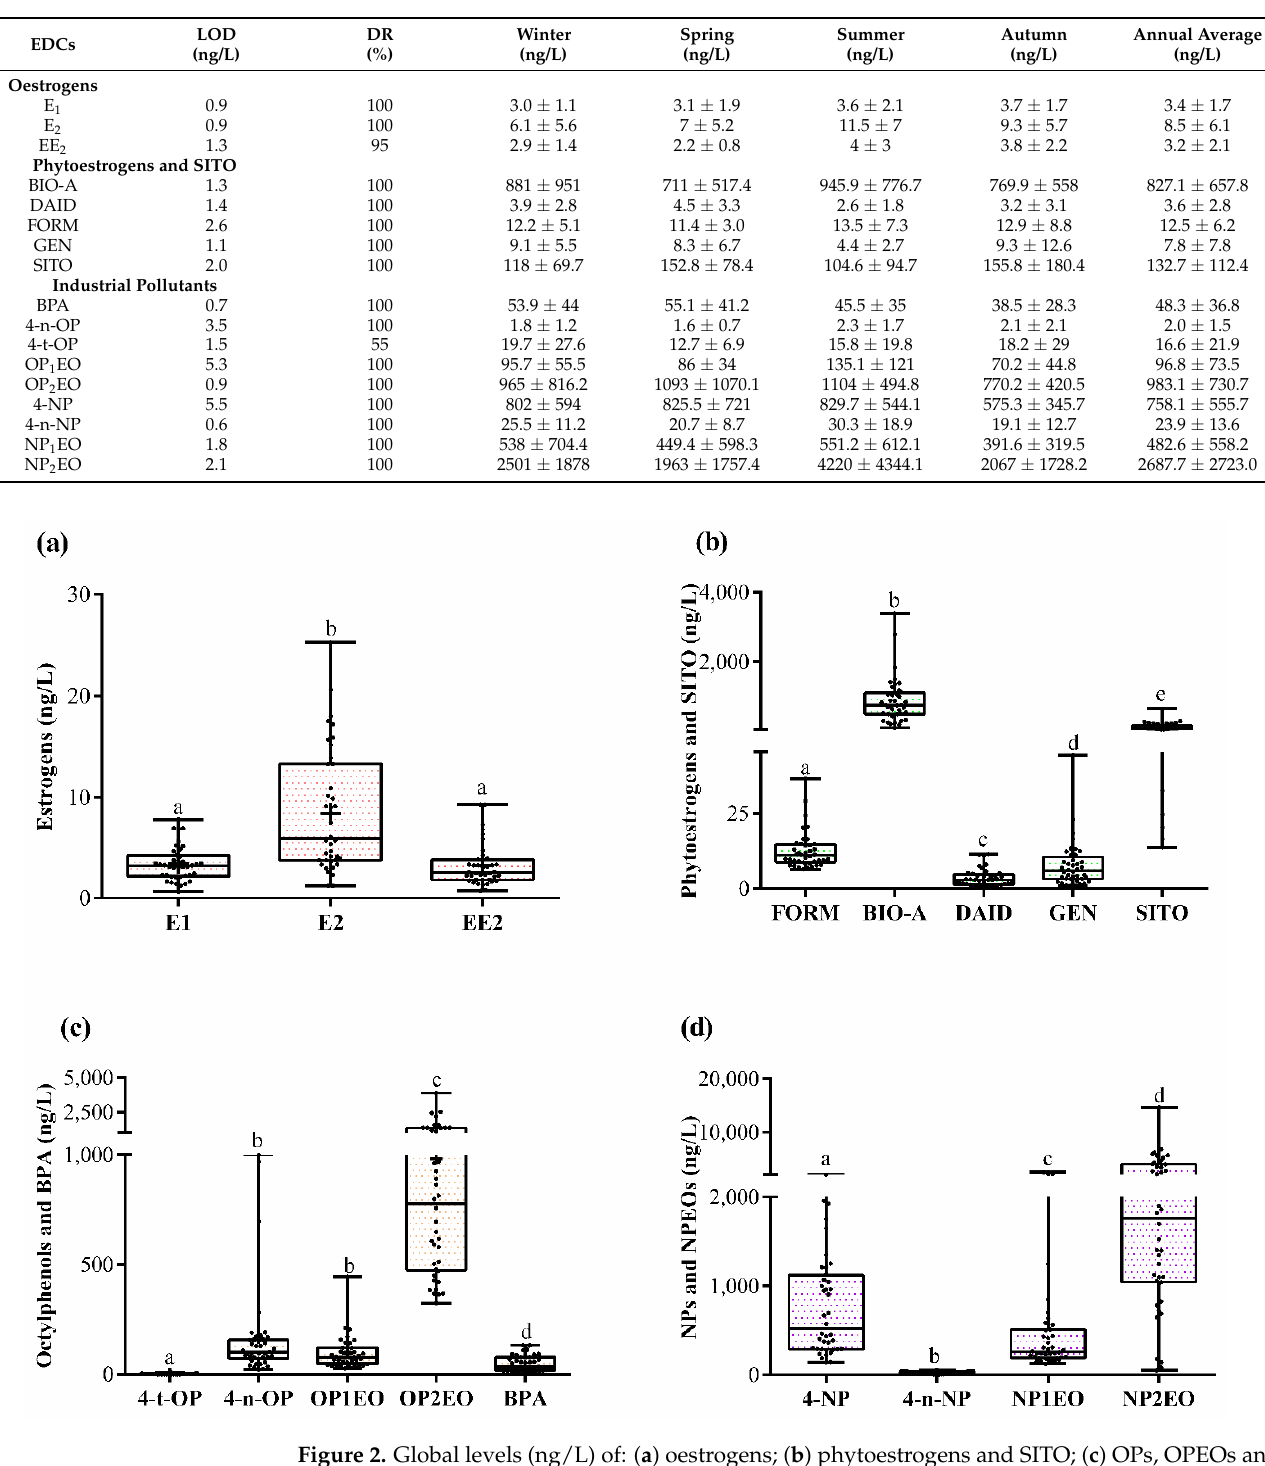
Table 1. Limits of detection (LOD), detection rate (DR), and levels of the seventeen EDCs analysed in surface waters of the Douro River estuary, presented as mean ± standard deviation.